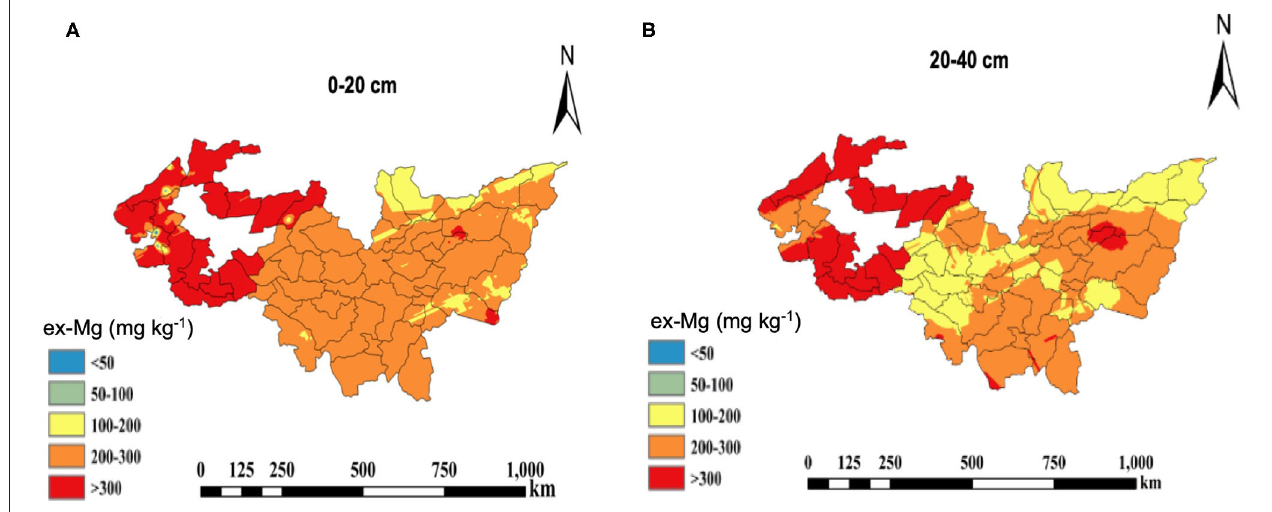
FIGURE 4 | Spatial distribution map of ex-Mg in the 0–20cm (A) and 20–40cm (B) paddy soil layers in Heilongjiang